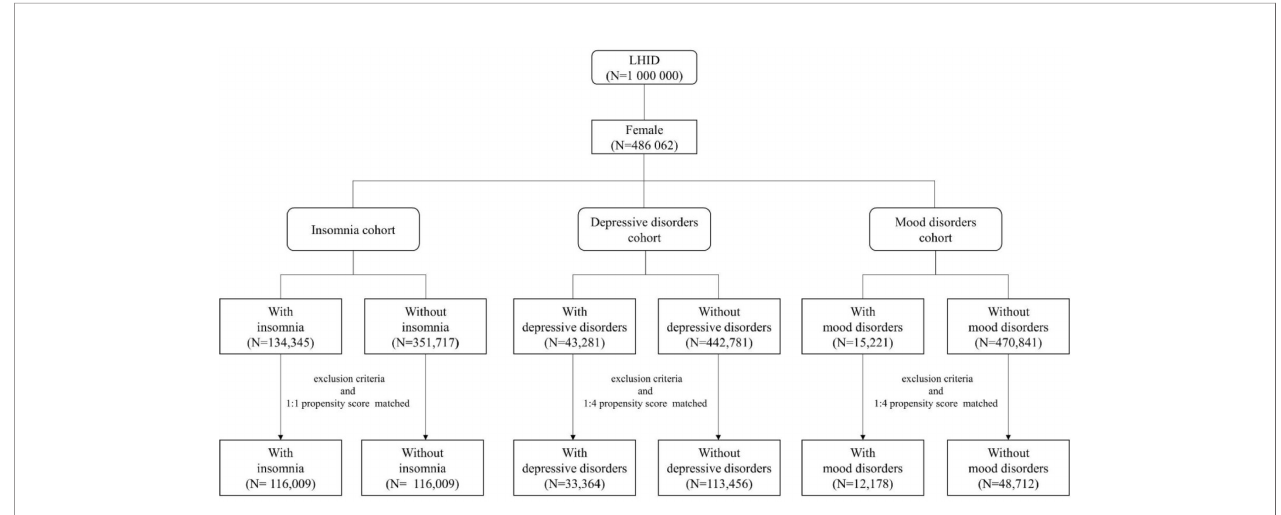
FIGURE 1 | The fl owchart of the three cohorts in this study: insomnia cohort, depressive disorder cohort, and mood disorder